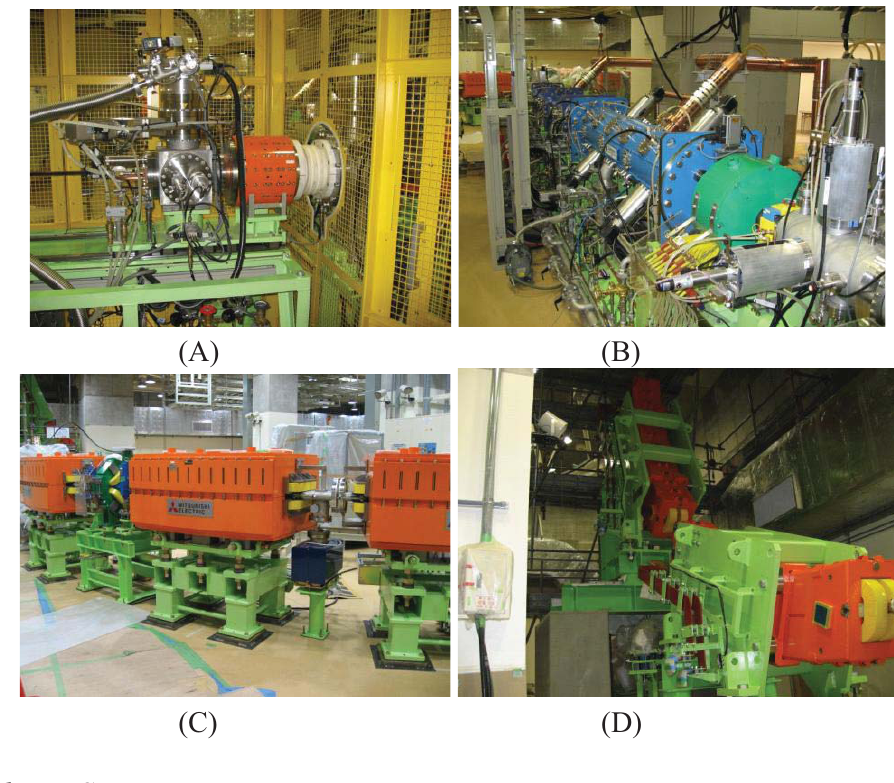
Figure 3. ( A ) 10 GHz carbon ion source; ( B ) RFQ linac and APF linac; ( C ) GHMC synchrotron ring; ( D ) High energy beam transfer line (vertical